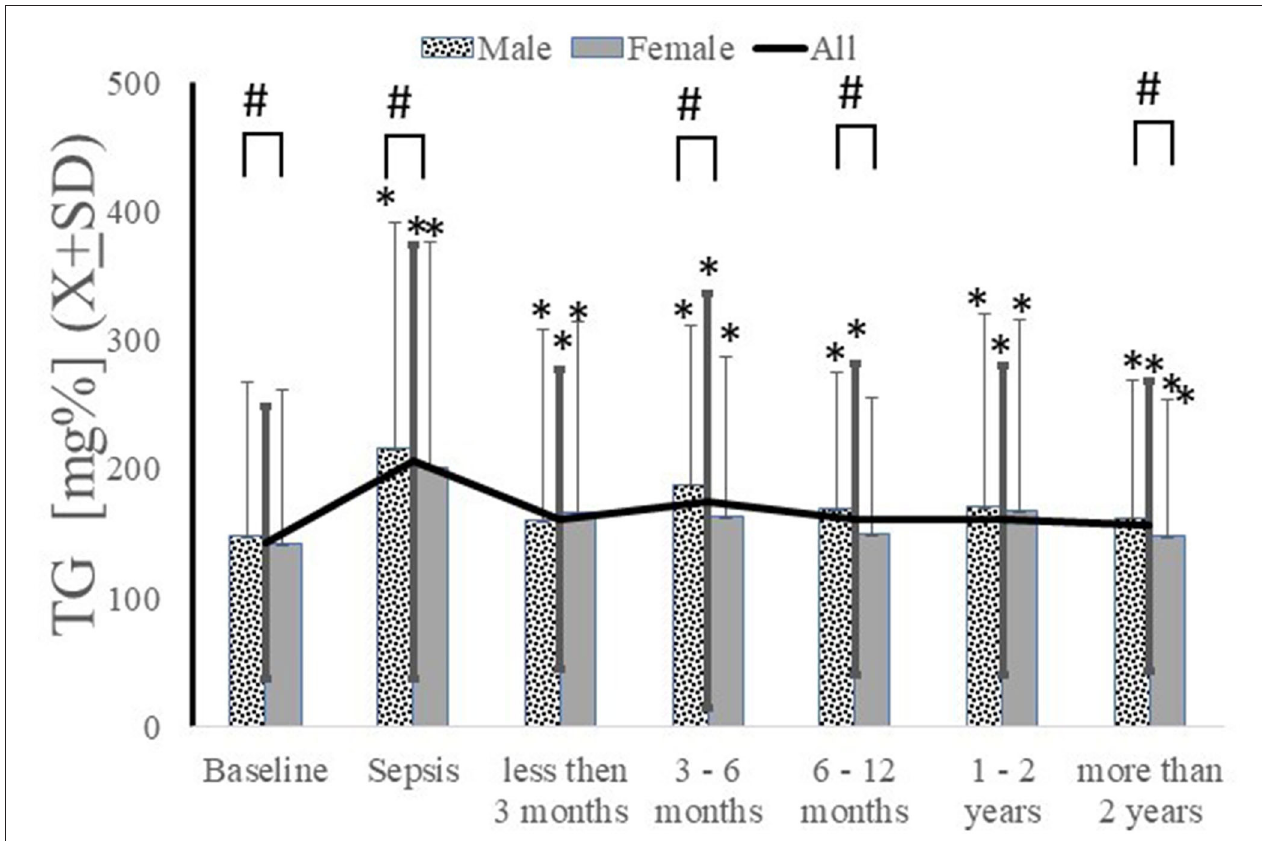
FIGURE 5 | Serum triglycerides increased during sepsis and remained elevated in both genders or longitudinally. * p < 0.05 as compared to baseline, # as compared between genders.